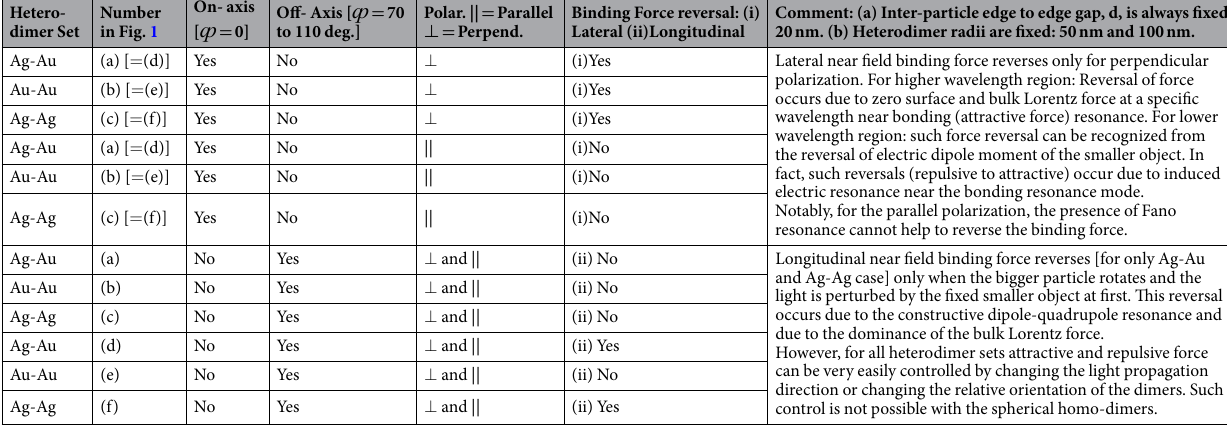
Table 1. An overview on the binding force for spherical heterodimers (only few possible